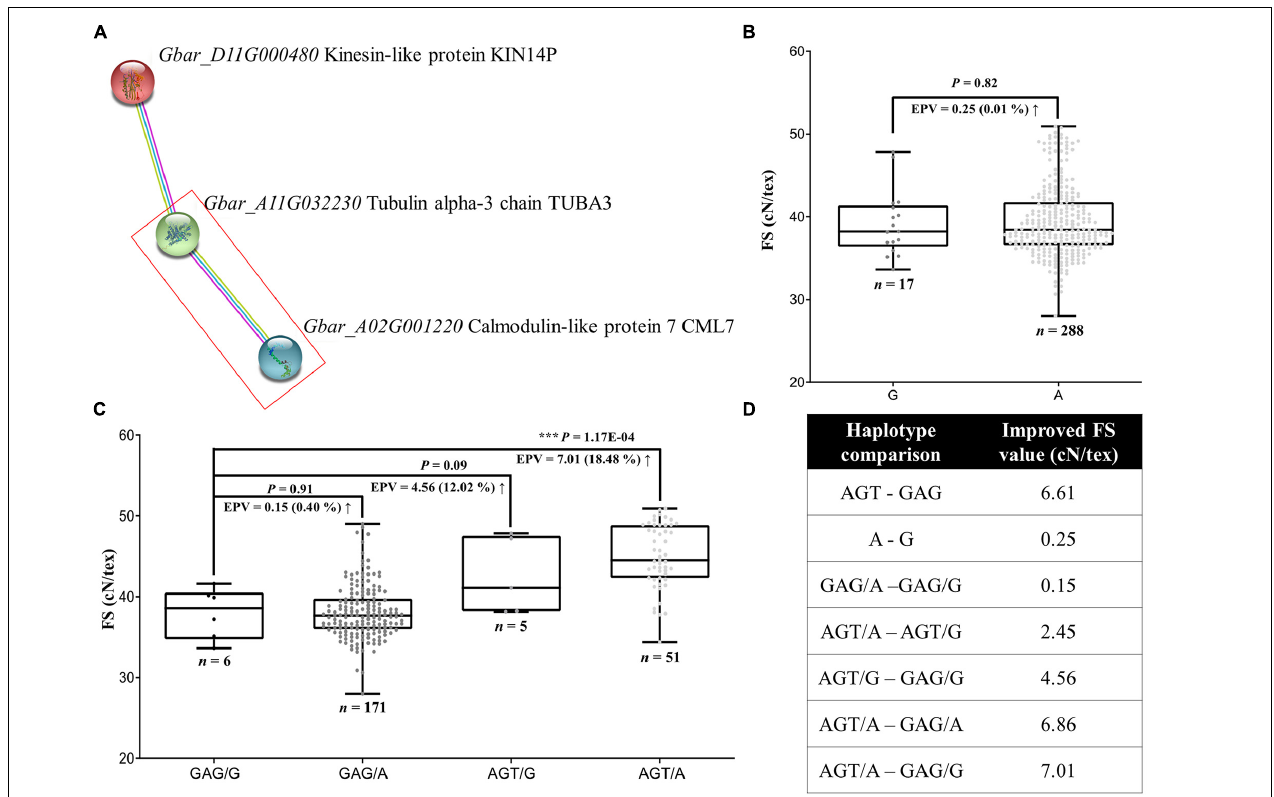
FIGURE 5 | Gene interaction between FS-related genes, GbCML7 and GbTUBA3 , and the resulting distribution of FS. (A) Interaction network among three FS-relate genes, including the key candidate GbCML7 . Colored circles represent proteins with known or predicted 3D structure inside. On the right are the names of the G. barbadense genes and encoded proteins. Colored lines between two circles represent the interaction relationship, where purple, blue, and yellow lines represent the source of that information, i.e., experimentally derived (purple), from curated databases (blue), and by text mining (yellow). (B) Fiber strength in accessions with the two main haplotypes of GbTUBA3 ( Gbar_A11G032230 ). n represents the number of accessions with that specific haplotype. Each point represents one accession. Accessions with the haplotype G are in dark gray and those with haplotype A are in light gray. Boxes span the first to third quartiles, center lines represent median values, and whiskers show the minimum and maximum. Significance differences in FS between the two groups of accessions with different haplotypes was analyzed using a two tailed t -test. *** indicates significant difference at P < 0.001. The up arrow indicates the increase of FS from the former to the latter. (C) Fiber strength in accessions with diverse interactive haplotypes between GbCML7 and GbTUBA3 . (D) Various improvement levels of FS in multiple comparisons of interaction